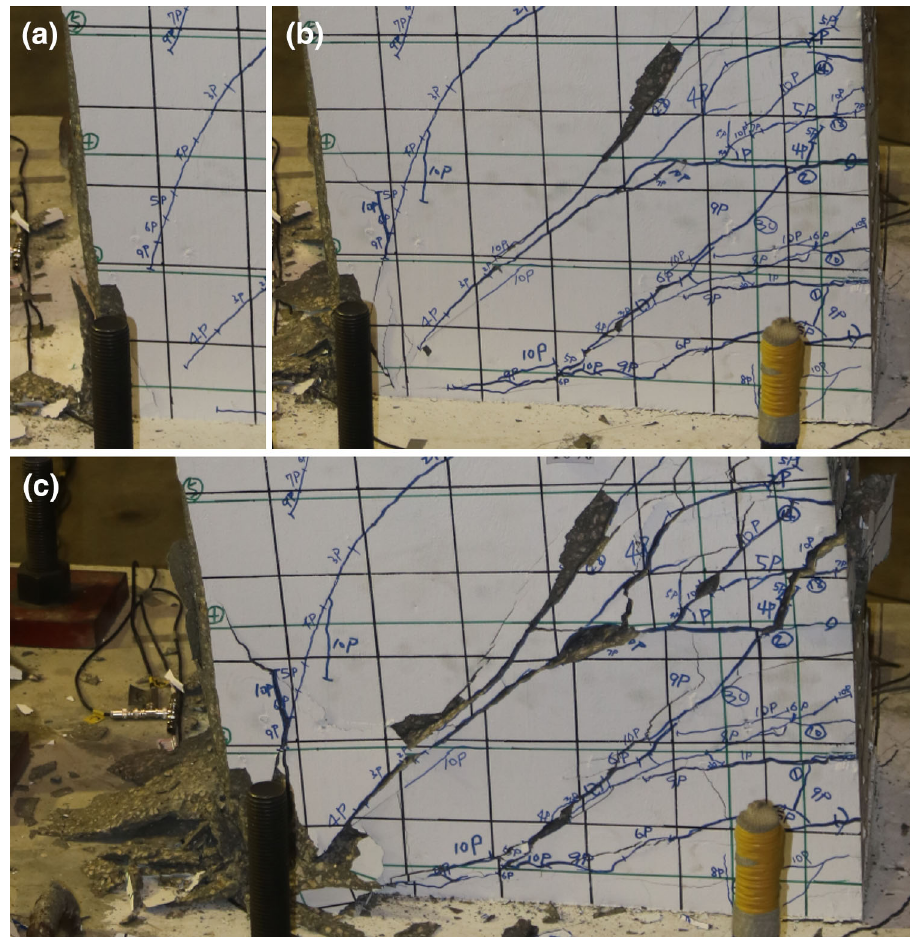
Fig. 11 a Concrete collapse on the compression side of the specimen (3%), b concrete cover spalling in the eastside of the specimen (6%), and c severe concrete collapse on the compression side of the specimen